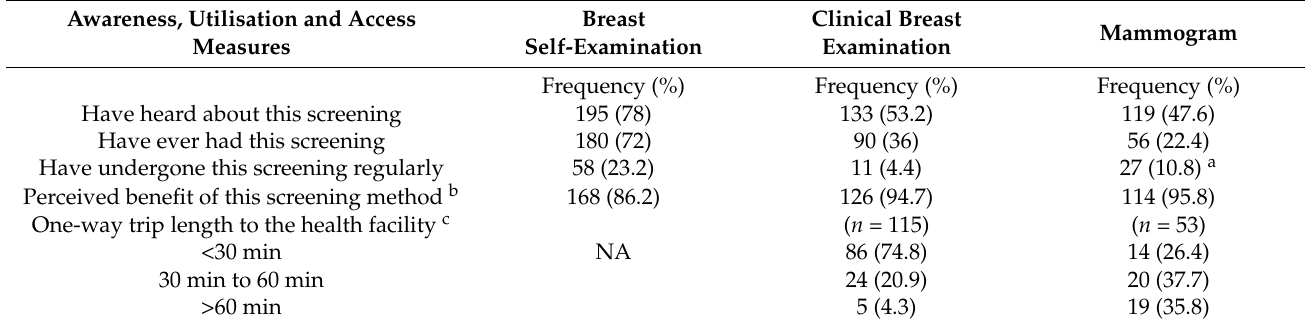
Table 2. Awareness, utilisation, and access to breast cancer screening modalities among the study participants. Awareness, Utilisation and Access